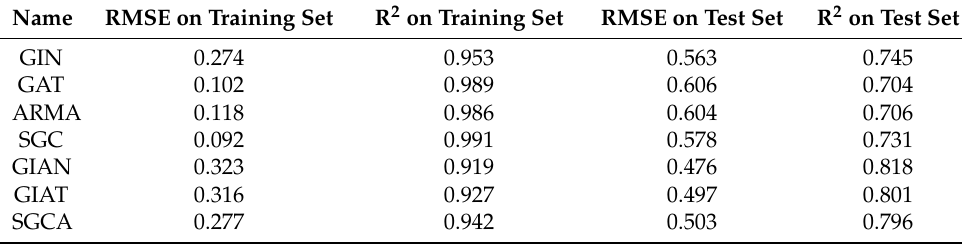
Table 2. Results of graph neural network (GNN) models and Multi-GNN